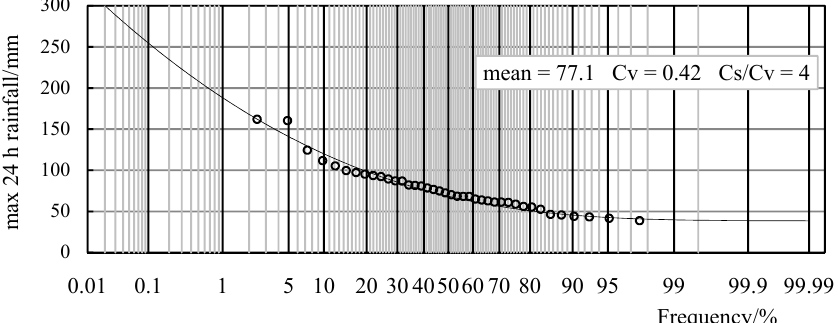
Figure 7. The frequency curve of the maximum 24 h rainfall of discontinuous 40 years in 1978~2020 at Wulongmiao station.